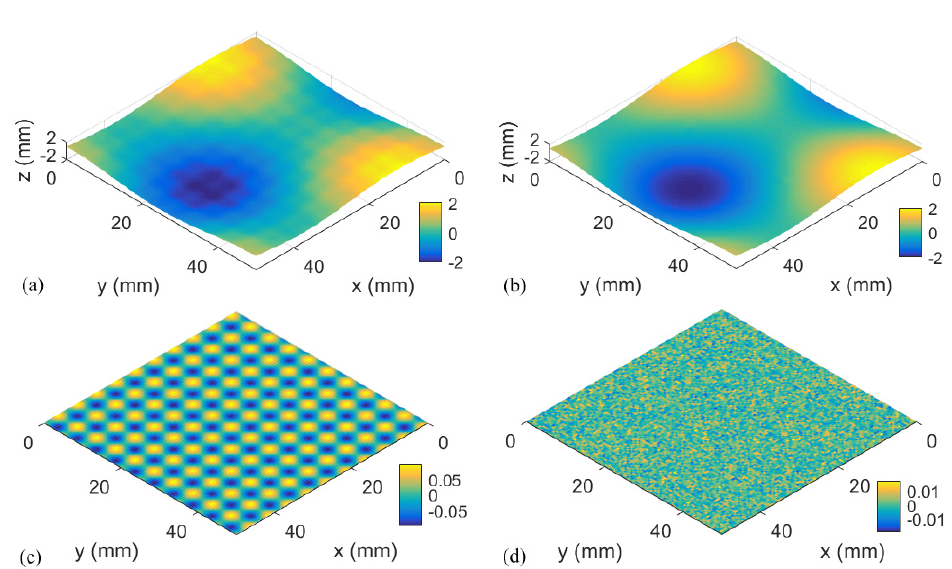
Figure 14. Simulated measurement result and components with different spatial frequencies: ( a ) measurement result; ( b ) base form; ( c ) machining error; and ( d ) measurement noise.